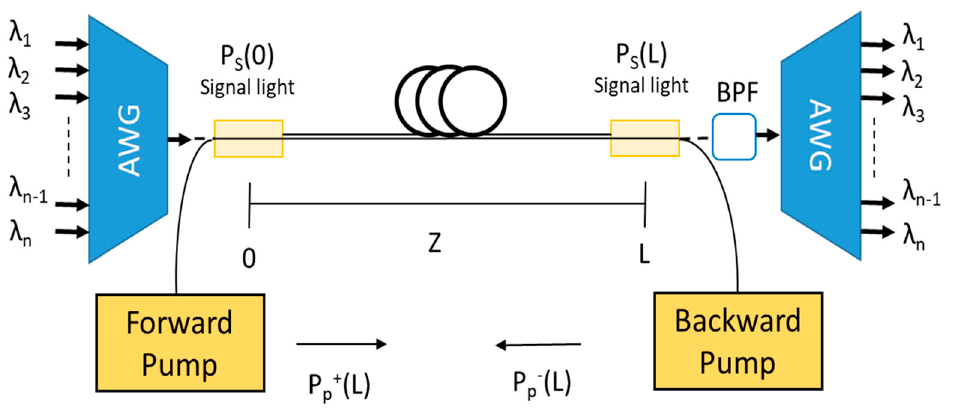
Figure 3. Schematic representation of multiplexing / demultiplexing based distributed optical Figure 3 . Schematic representation of multiplexing/demultiplexing based distributed optical Raman Raman amplifier. amplifier.